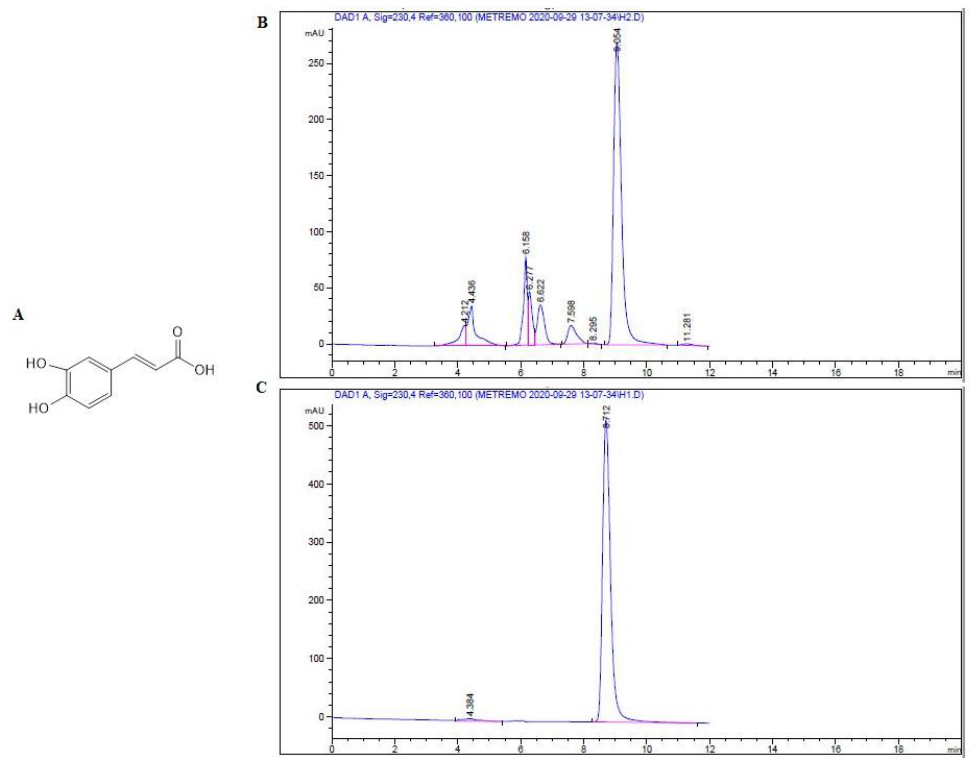
Figure 1. Structure of caffeic acid (CAF) isolated from T. stellata ( A ). HPLC chromatogram of SubFr.